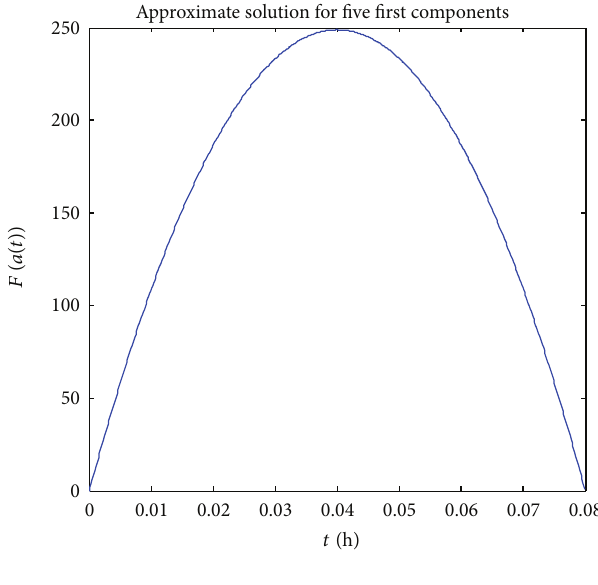
Figure 4: Approximate solution of the contact force in the elastic indentation phase (27) with 𝛽 = 2 .